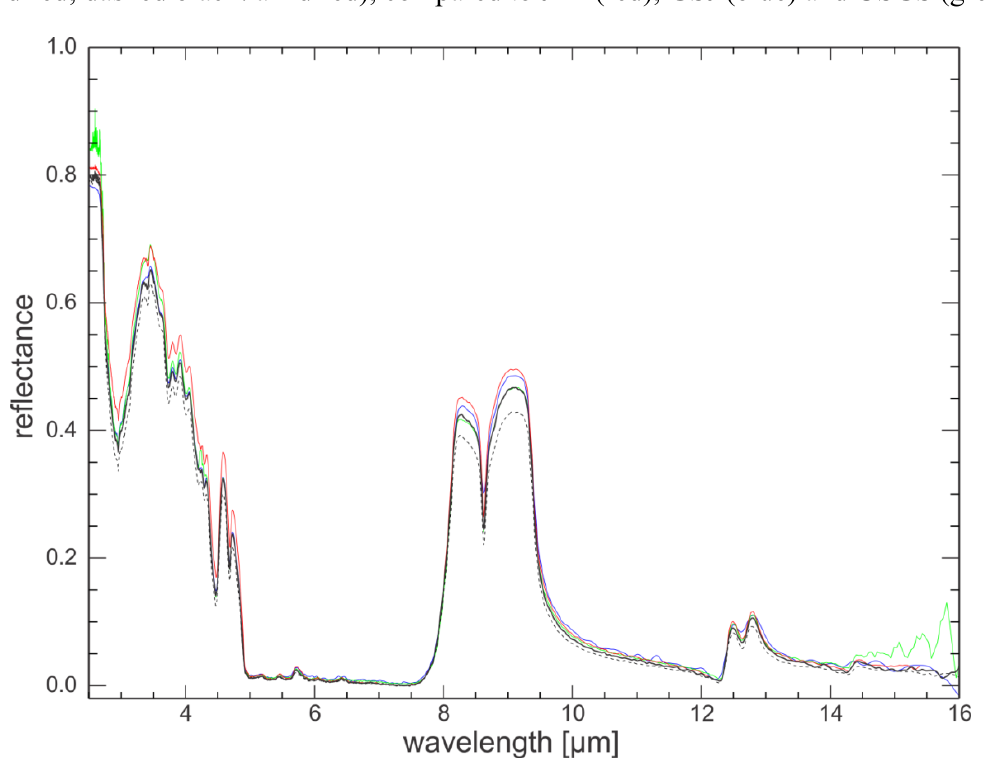
Figure 8. Spectra of the same quartz sand standard measured by UT-ITC (solid black: oven-dried; dashed black: air-dried), compared to JPL (red), GSJ (blue) and USGS